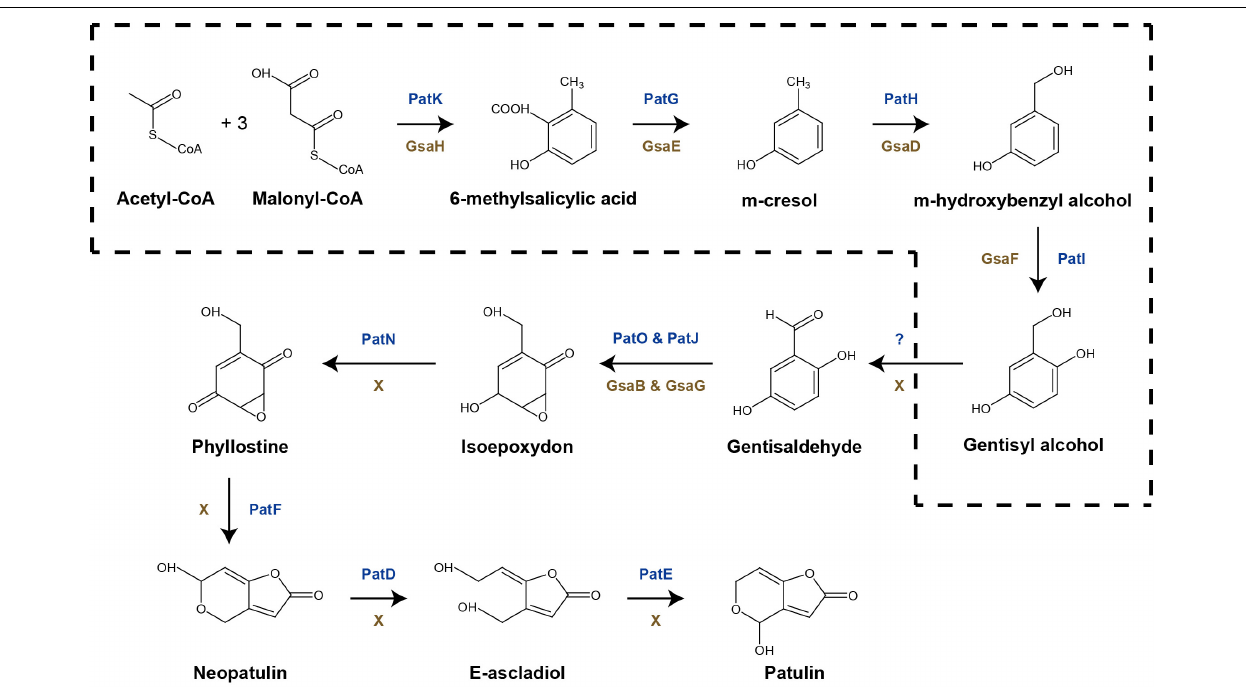
FIGURE 5 | Proposed scheme of gentisyl alcohol biosynthetic pathway in Arthrinium spp. (dotted box) expressed in the patulin biosynthetic pathway.